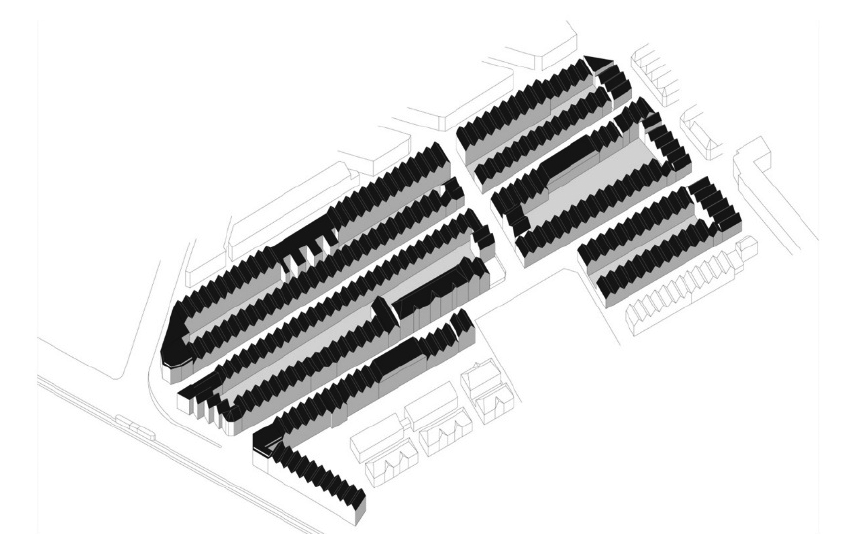
Figure 3. Deelgebied 5 (Schilderswijk, The Hague). The situation in the late 1970s. Author’s drawing. Over the following months, Siza revised an existing plan for the area developed by the municipality’s DSO.